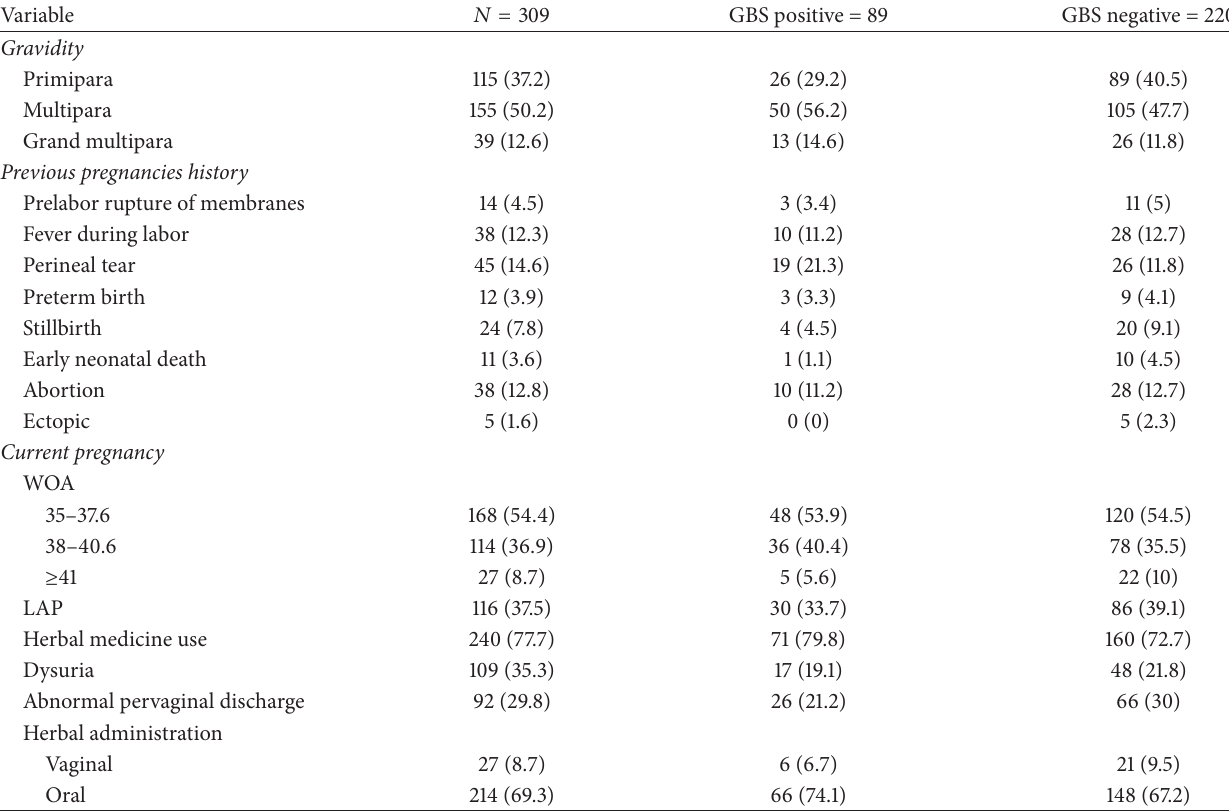
Table 2: Participants’ obstetric and clinical